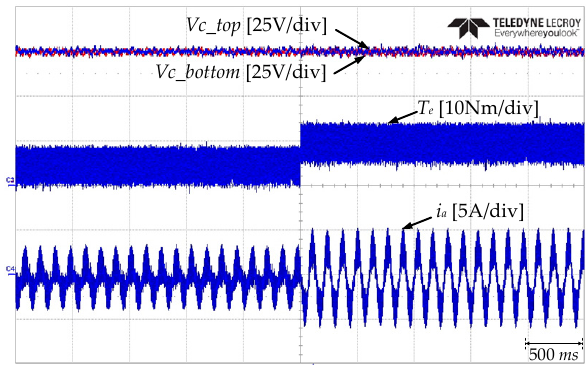
Figure 16. Experimental result of the transient-state operation under neutral-point balancing at 150 r/min.